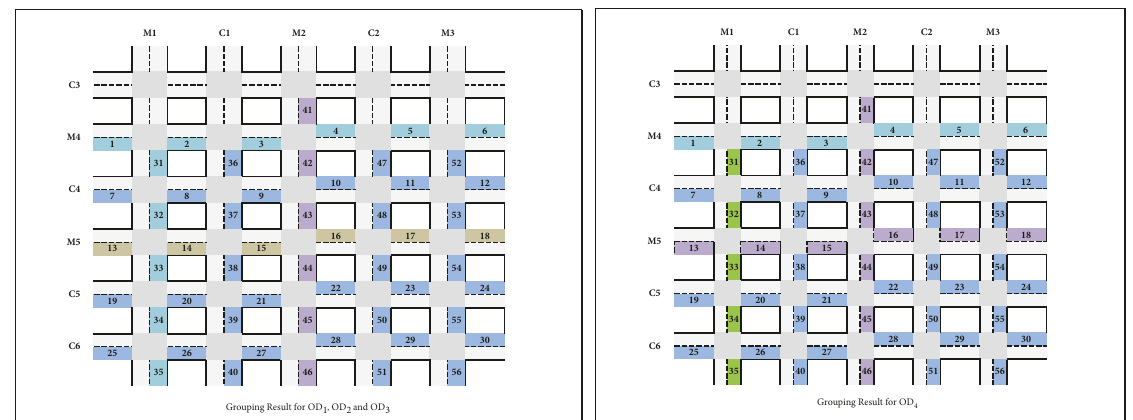
Figure 4: Grouping results for different kinds of ODs.